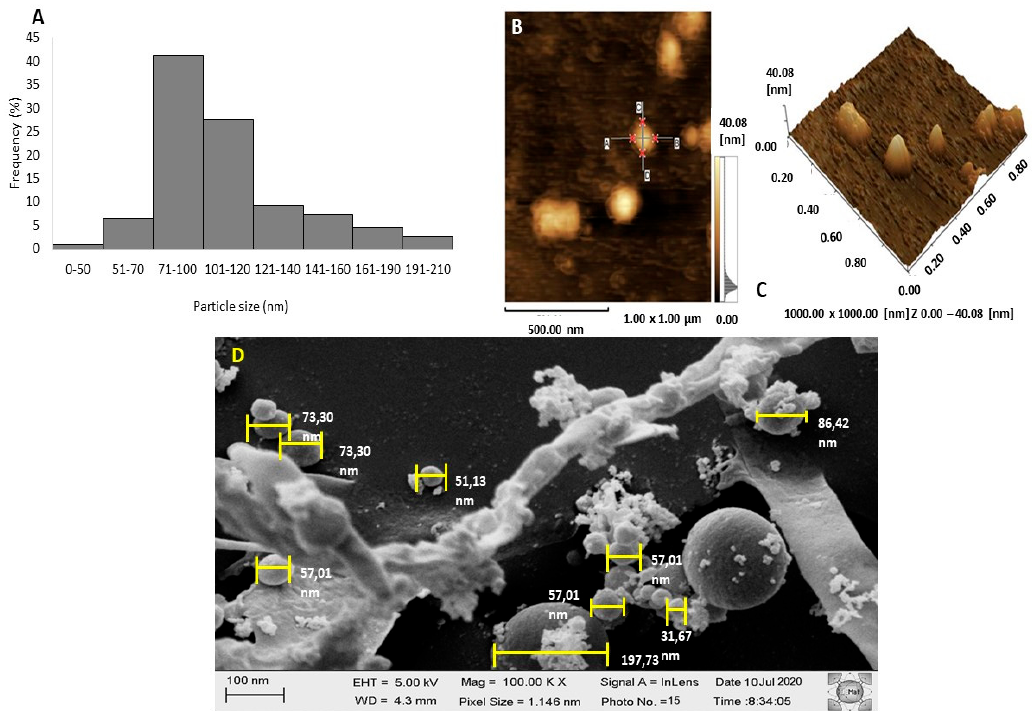
Figure 3. Physical attributes of the nanoxylan particles. ( A ) Size dispersion histogram obtained using dynamic light scattering (DLS). ( B and C ) AFM images of the nanoxylan particles. ( B ) Nanoxylan in two dimensions, with two planes drawn in red; ( C ) nanoxylan in three dimensions; ( D ) SEM image of the nanoxylan particles.